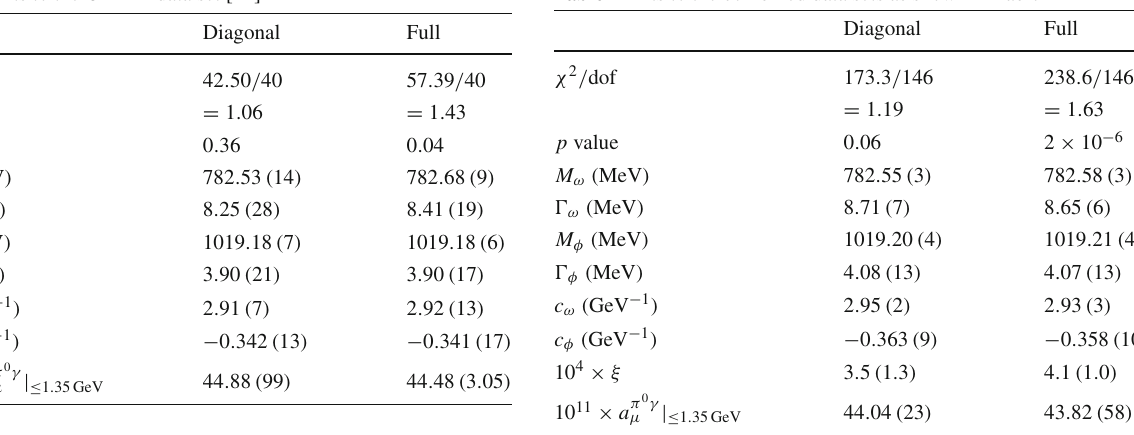
Table 3 Fits to the CMD-2 data set [11] Table 4 Fits to the combined data sets as shown in Table